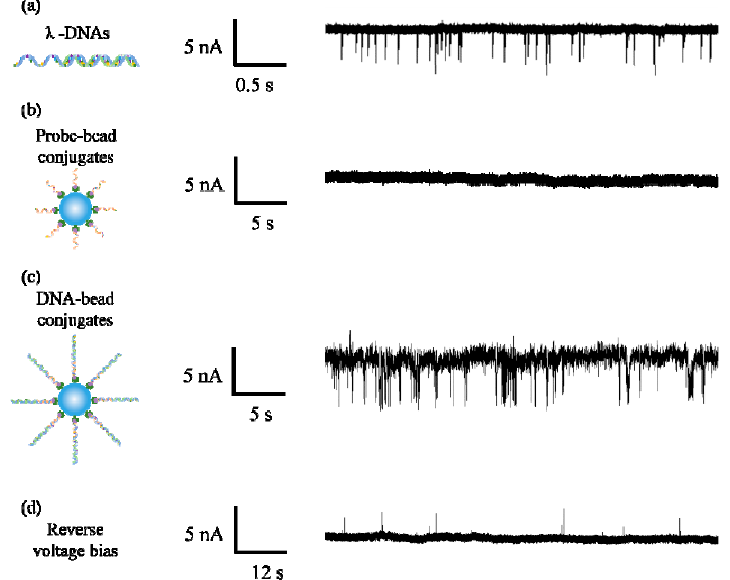
Figure 3. Ionic current traces for ( a ) λ -DNAs, ( b ) probe–bead conjugates and ( c ) DNA–bead conjugates; ( d ) ionic current trace measured under reversed the bias voltage.